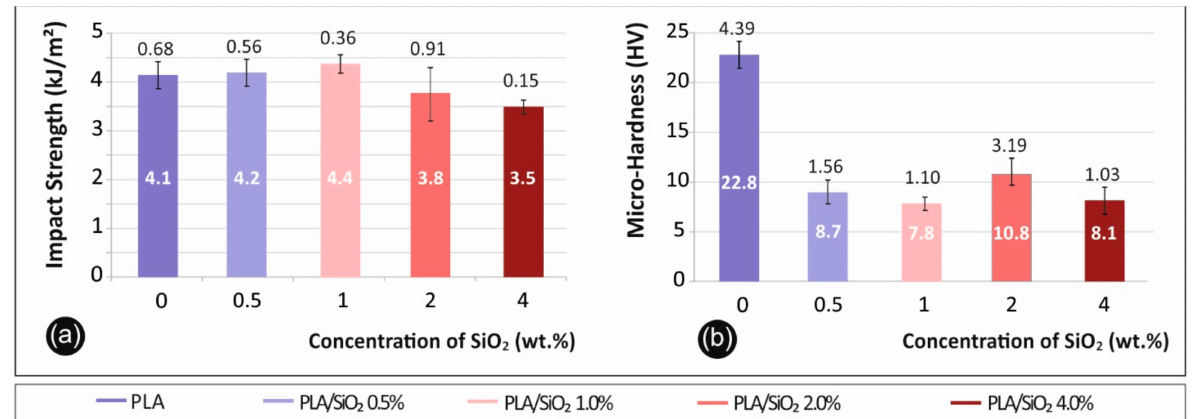
Figure 5. ( a ) Impact strength (kJ/m 2 ) to filler percentage (%) in PLA (0.5% wt. developed 0.6% increased values, when compared to pure PLA, 1% wt. 5.4% increase, 2% wt. 8.7% decrease and 4% wt. 15.8% decrease, respectively) ( b ) Vickers microhardness (HV) to filler percentage (%) (0.5% wt. developed 63.7% decreased values, when compared to pure PLA, 1% wt. 65.7% decrease, 2% wt. 52.4% decrease and 4% wt. 64.4% decrease,